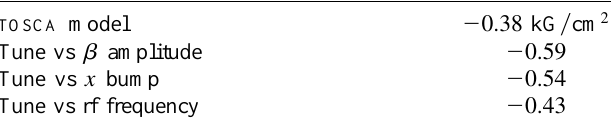
TABLE I. Cubic term in the horizontal equation of motion.